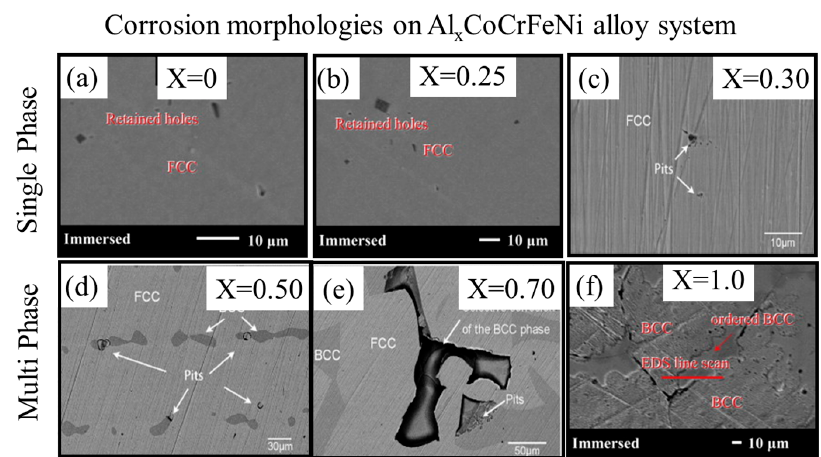
Figure 7. Pitting morphology on Al x CoCrFeNi alloys after polarization experiments. The microstructure of the alloys with ( a ) Al = 0; ( b ) Al = 0.25; and ( c ) Al = 0.3 was reported to be of single phase, and consequent absence of galvanic corrosion sites. The microstructures with Al = 0.5–1.0 showed two-phase microstructure. This promoted accelerated corrosion at the interface between the two-phases ( d ) pits on face centered cubic-face centered cubic (FCC-FCC) interphase boundary; ( e ) BCC-BCC interphase boundary and ( f ) corrosion on ordered BCC phases [34] (reprinted with permission from Elsevier).